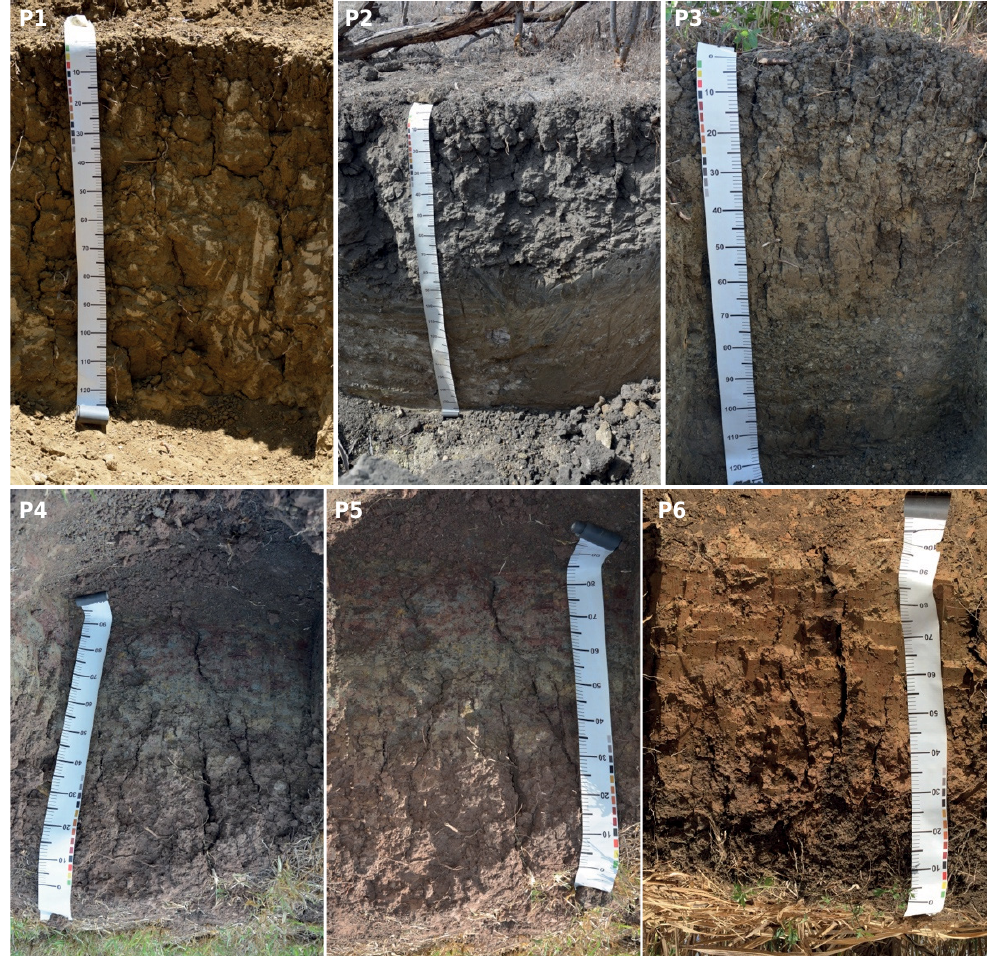
Figure 1. Soil profiles sampled in Juazeiro County, Semiarid region of Bahia State (P01, P02, and P03), and Recôncavo region (P04, P05, and P06).